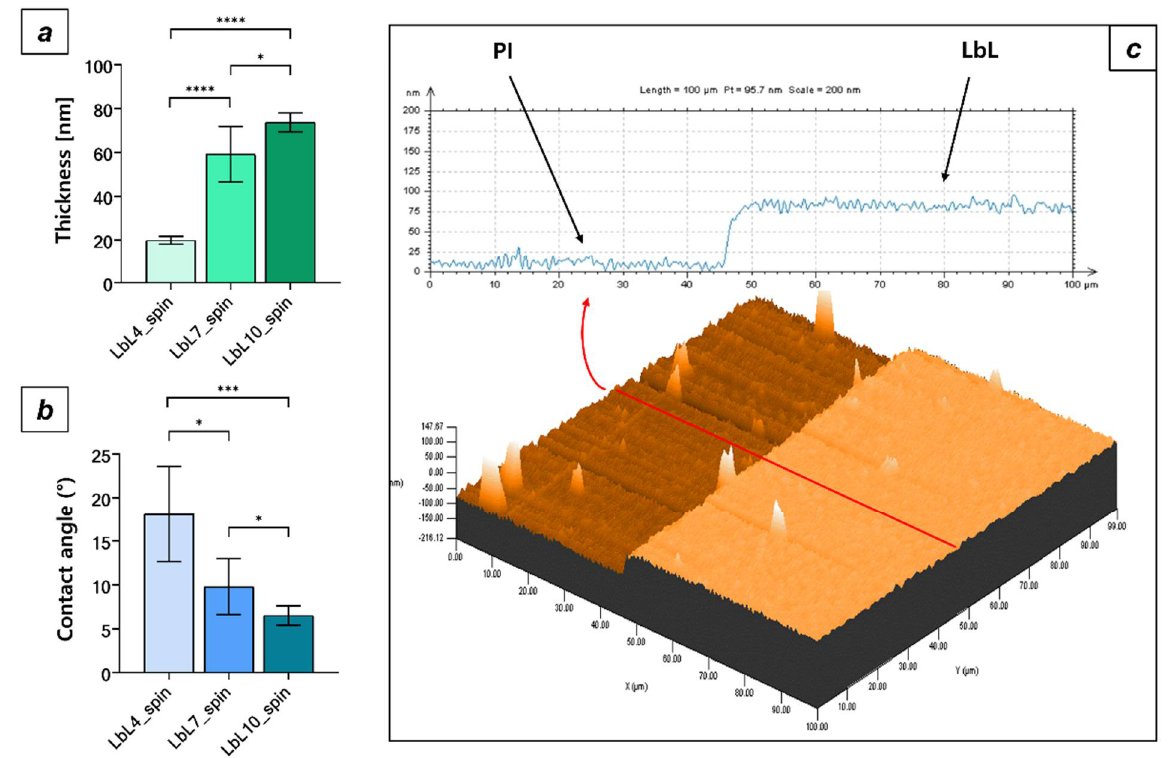
Figure 5. LbL assembly by spin coating. Thickness data ( a ) and CA values ( b ) of LbL assembly onto PI surface after the deposition of 4 (LbL4_spin), 7 (LbL7_spin), and 10 (LbL10_spin) polysaccharide bilayers. ( c ) 3D reconstruction of a 100 μm × 100 μm surface profilometry referred to a LbL10_spin sample and plot of surface roughness profile relative to the red line across the scratch showing the presence of an LbL multilayer coating on the surface of the PI.